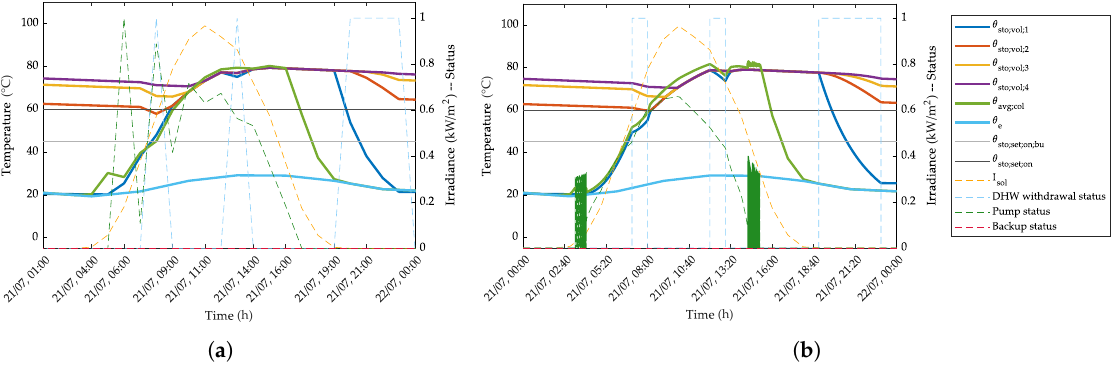
Figure 15. The effect of the time step on simulations featuring modulating control: ( a ) t o ci = 1 h, and ( b ) t o ci = 5